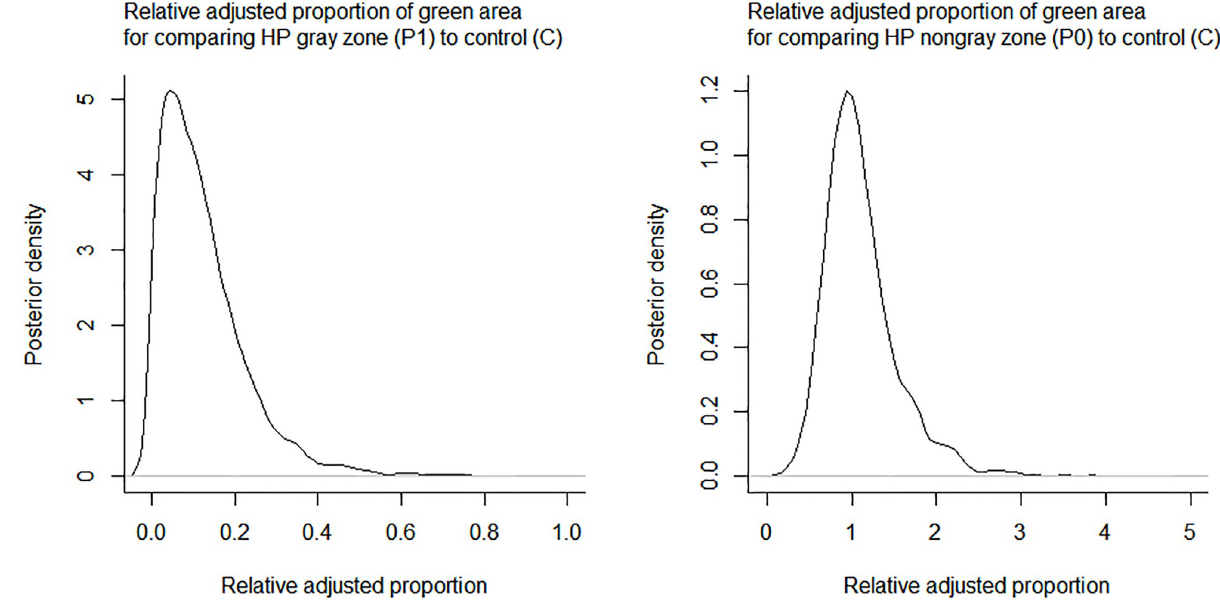
Fig 6. The approximate posterior distributions of θ 1 (5) / θ C (5) and θ 0 (5) / θ C (5) (left panel and right panel,